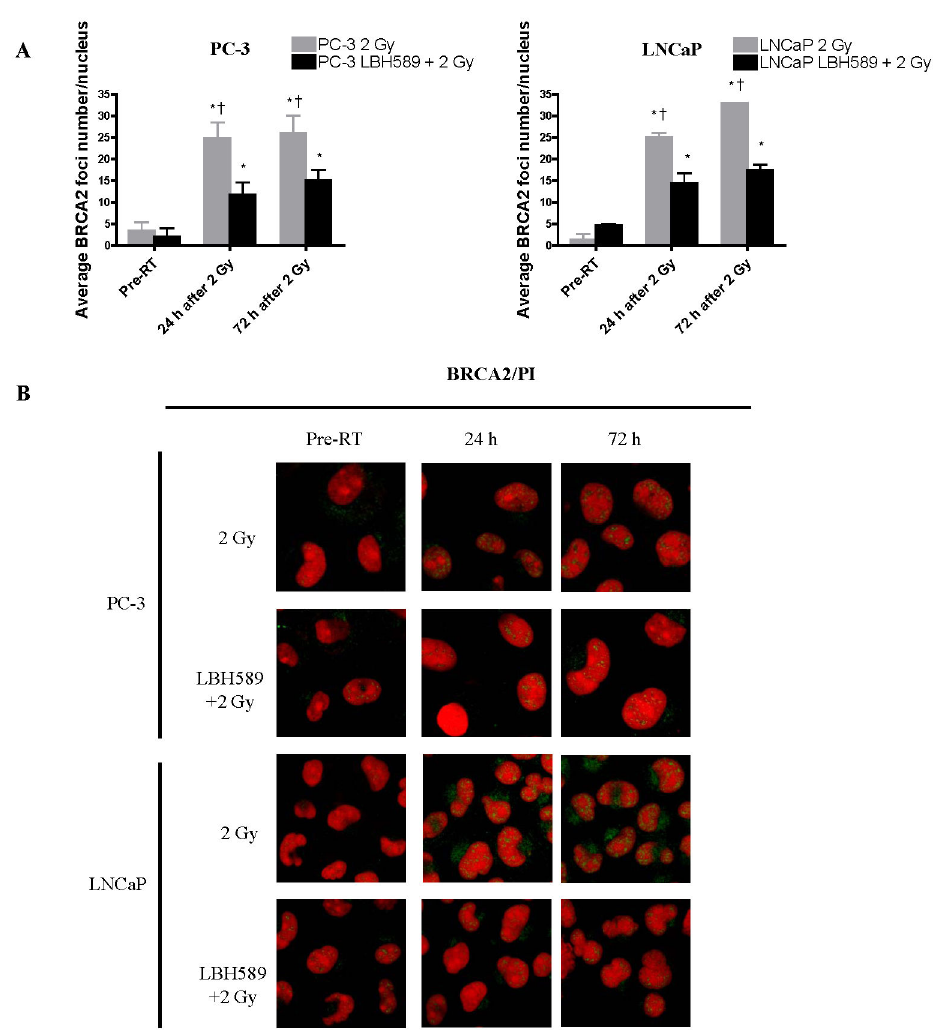
Figure 6. Quantitative analysis of DSB repair marker in the HR pathway for BRCA2 foci at pre-RT, 24 h and 72 h after 2 Gy RT or combination treatment in PC-3 and LNCaP cells. ( A ) After 2 Gy RT, average BRCA2 foci number increased significantly at 24 h in both PC-3 and LNCaP cells and maintained increased at 72 h, while average BRCA1 foci number in combination-treated (LBH589+2 Gy RT) cells was also increased at 24 and 72 h, but was significantly lower than that in RT-treated cells. ( B ) Representative images of BRCA2 staining after 2 Gy RT or combination treatment (LBH589+2 Gy RT) in PC-3 and LNCaP cells. p <0.05(†) indicates significant difference between RT-treated cells and combination-treated cells at the same time point. p <0.05(*) indicates significant difference between cells at specific time points and cells receiving the same treatment at the “Pre-RT” time point. Points, mean; bars, SD. N=50. Typical images are shown from three independent experiments (N=3). Magnification × 60 in all